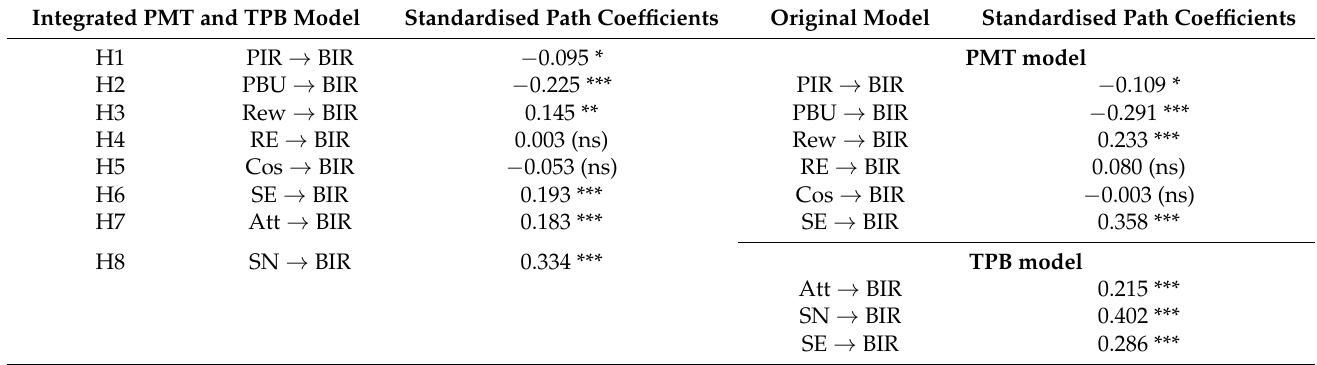
Table 5. Model fit test